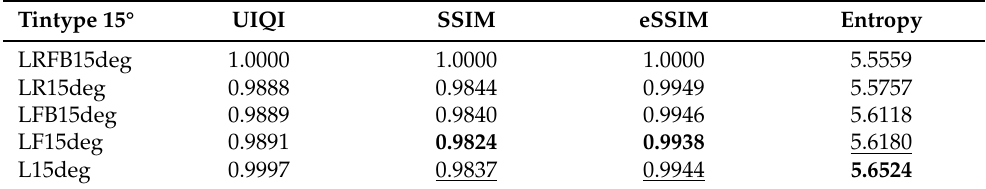
Table 6. Tintype 15°. Comparison of images scanned in different scan modes with a reference image scanned in LRFB 15°